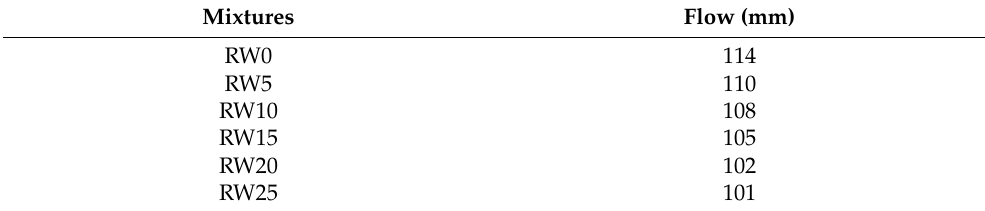
Table 7. Flow results of tested